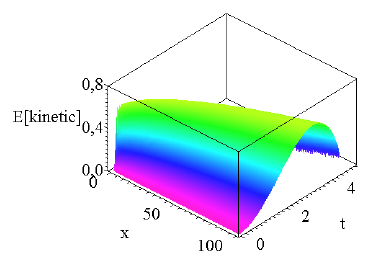
Figure 6. The “kinetic energy-like property” of the wave according to Equation (26) with all numerical parameters given